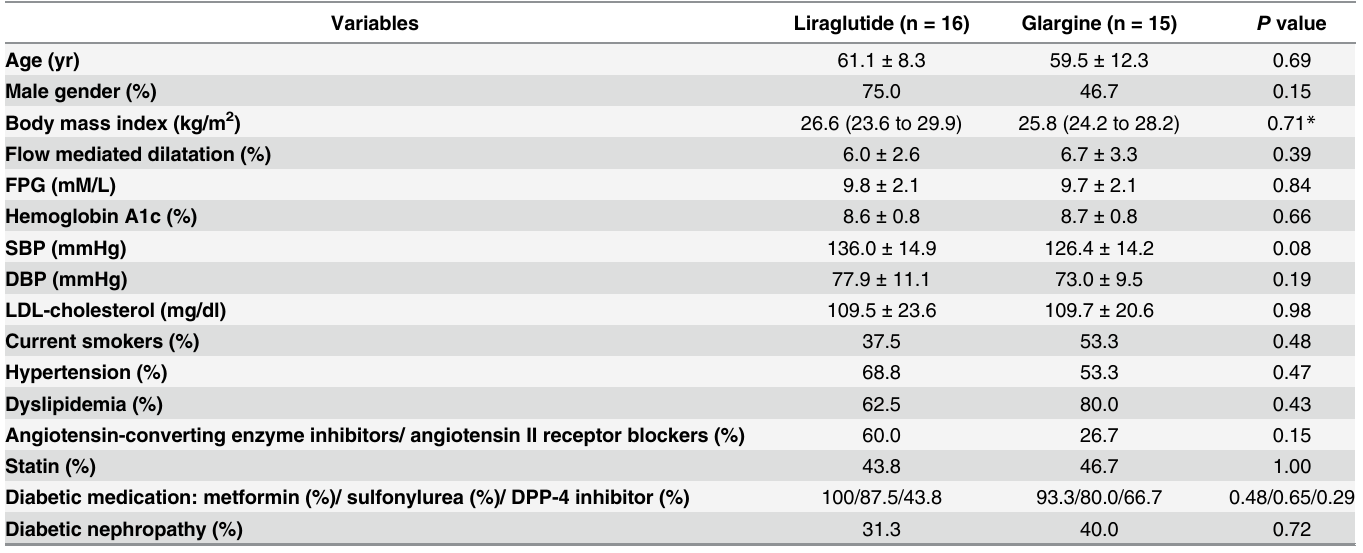
Table 1. Clinical characteristics of the study population.